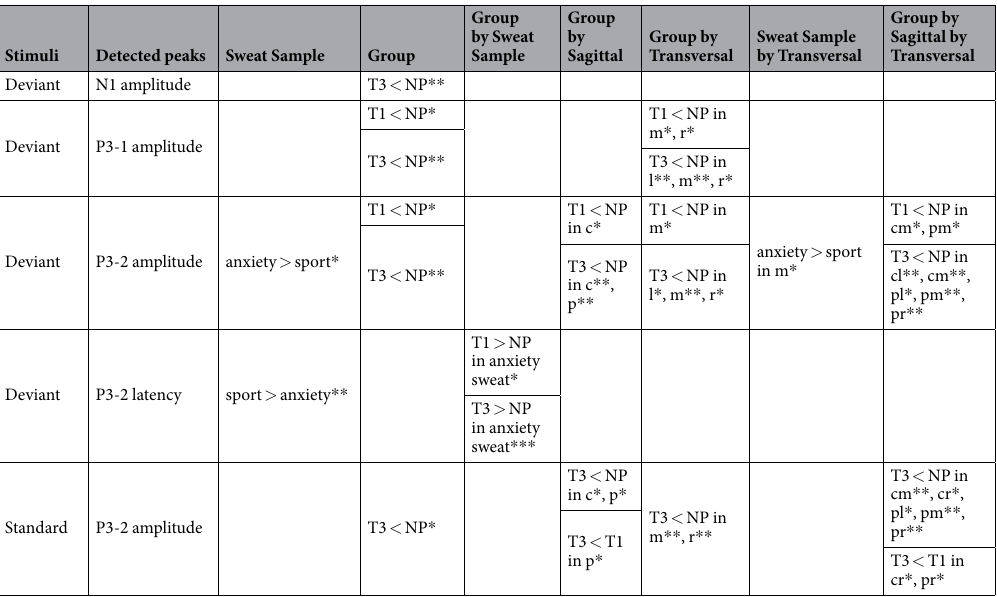
Table 3. CSERP in response to deviant and standard stimuli: Overall analysis of variance of amplitudes and latencies. Significant main effects, interactions, and single comparisons. Notes: anxiety = anxiety sweat, sport = sport sweat; NP = non-pregnant women, T1 = women in their first trimester of pregnancy, T3 = women in their third trimester of pregnancy; Sagittal line: a = anterior, c = central, p = posterior; Transversal line: l = left, m = midline, r = right, * p ≤ 0.05, ** p ≤ 0.01, *** p ≤